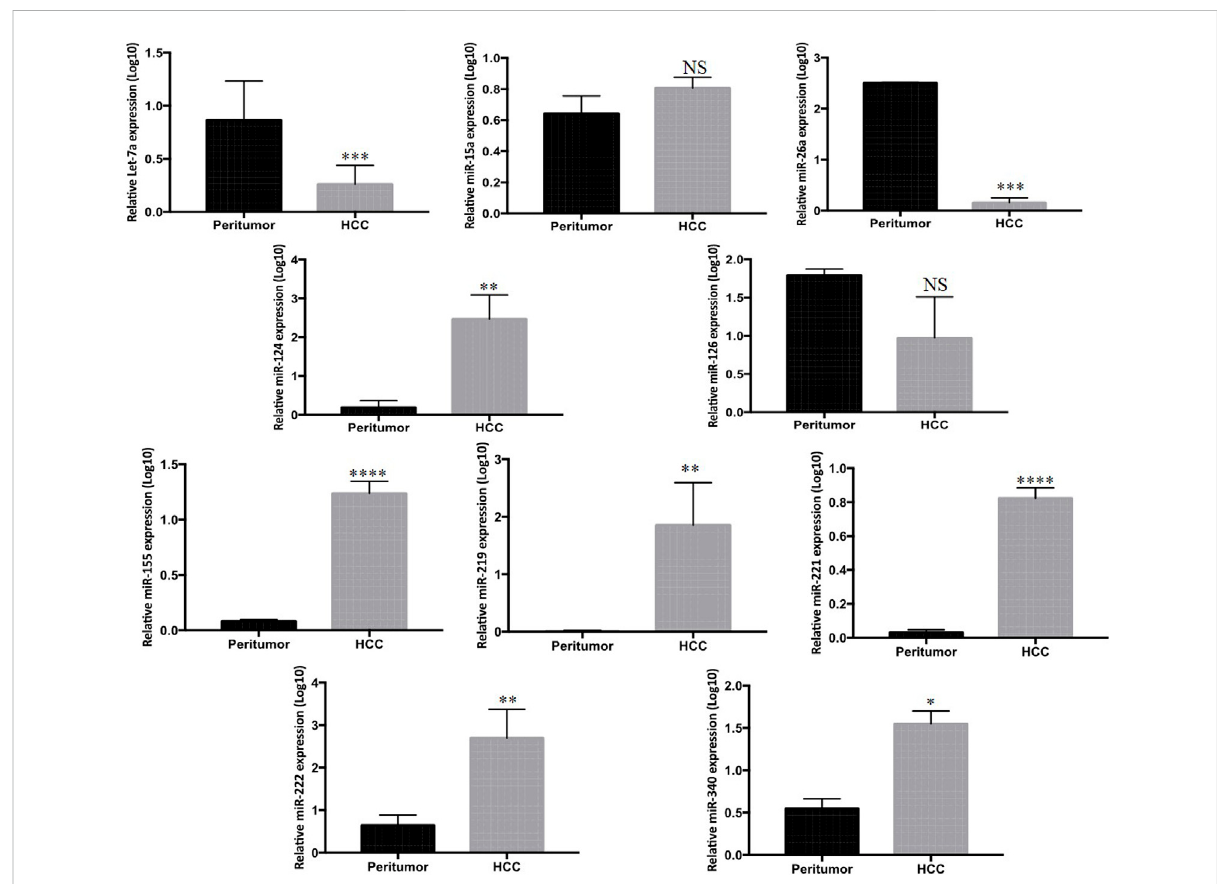
FIGURE 2 Mean log 10 expression of ten candidate miRNAs in tumor of HCC patients ( n = 33) compared to paired peritumor tissue ( n = 33) determined by Rt-qPCR.ThestatisticalanalysiswasperformedusingMann – Whitneytest(GraphPadPrism5.0).Thestatisticallysigni fi cant p -valuewasdenotedas < 0.05. NS; non-signi fi